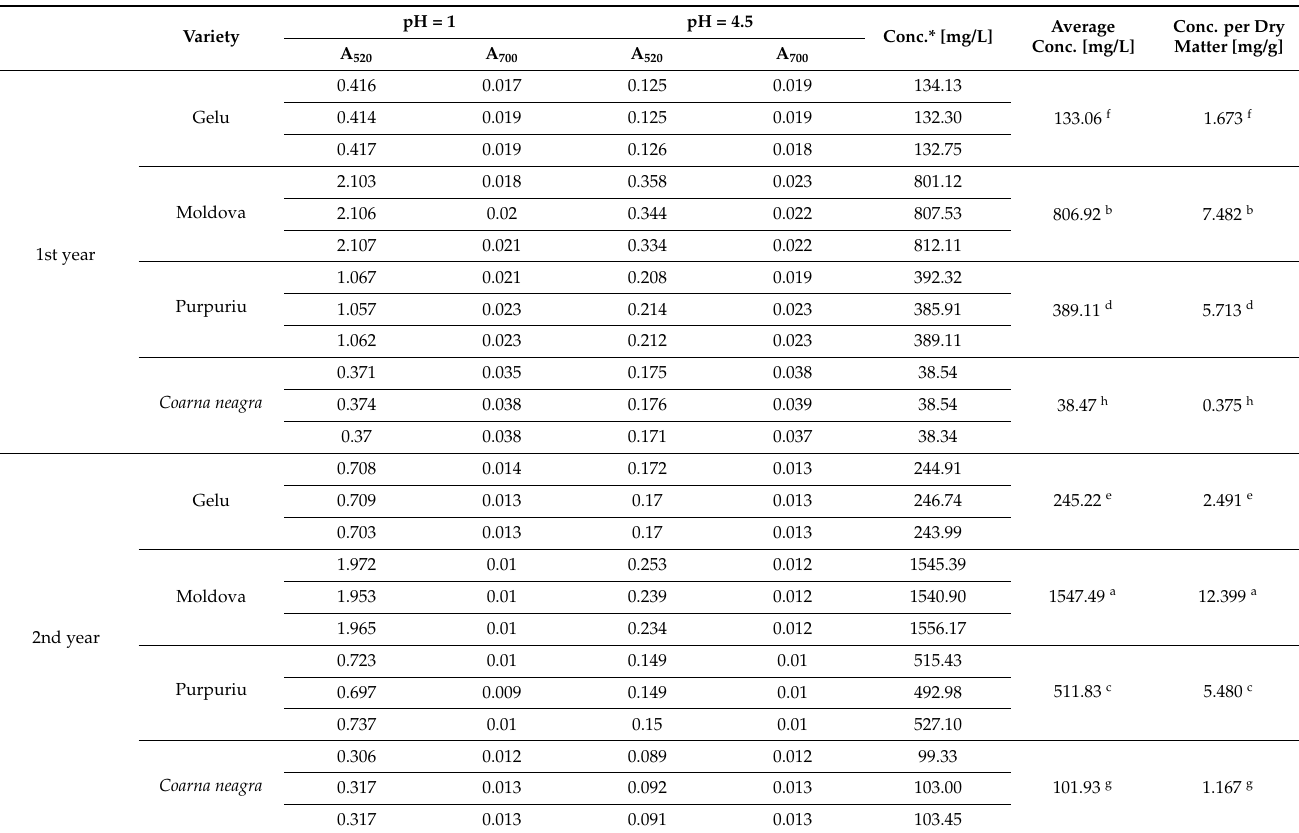
Table 3. Total anthocyanin concentrations in the grape skins (mg/L) for the studied varieties in both